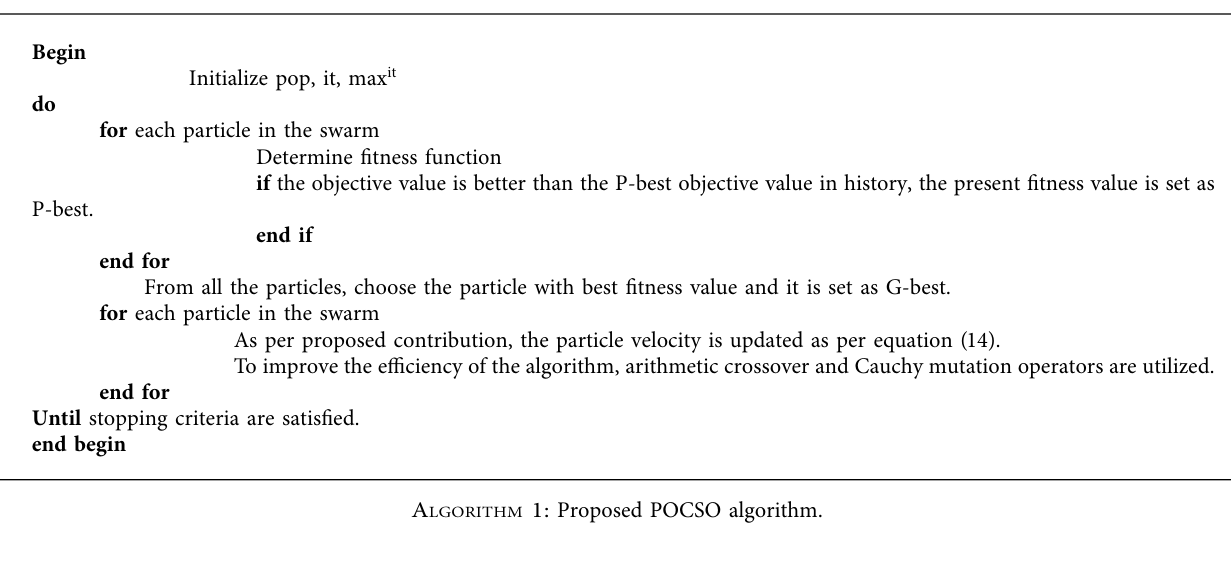
Table 1: Optimal turbine selection.